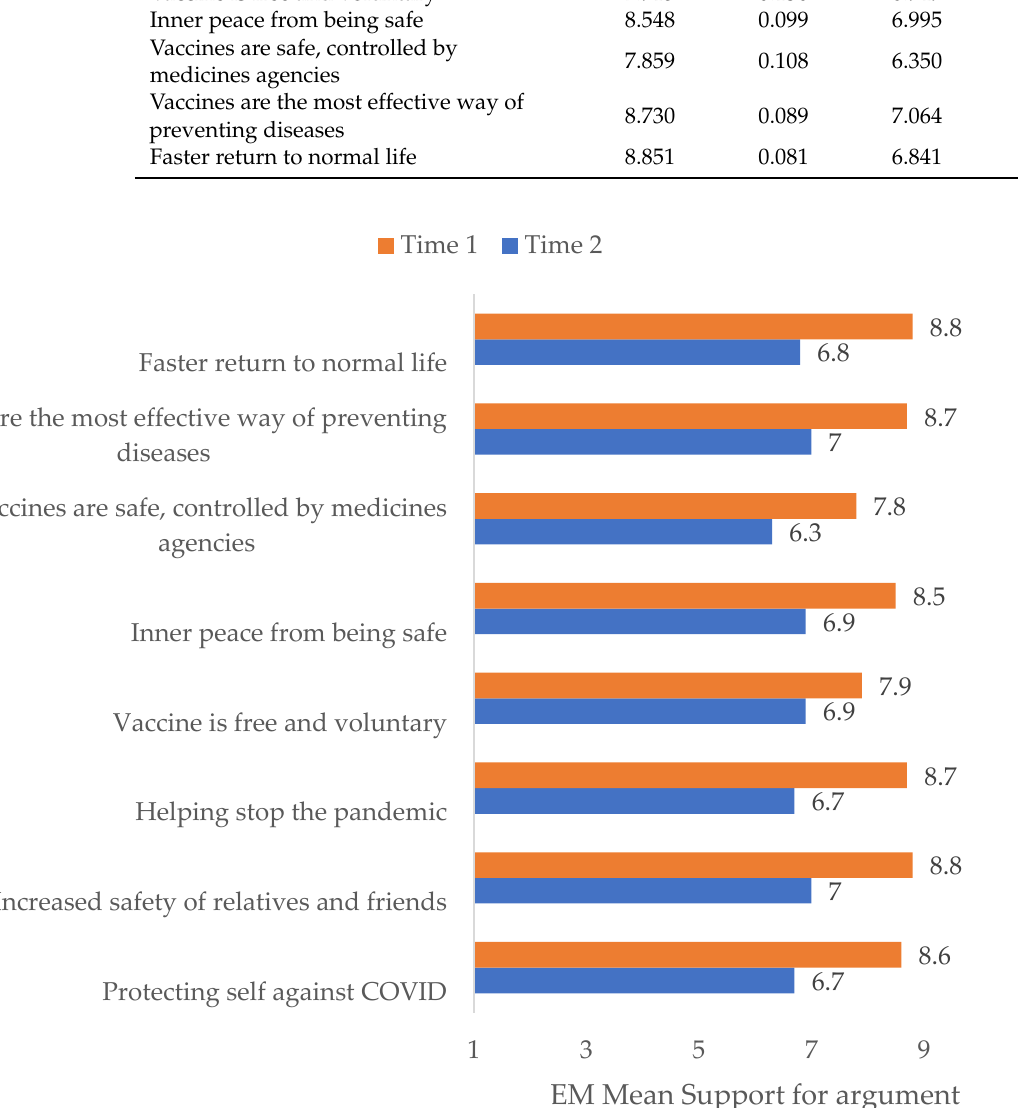
Figure 2. Reasons to get vaccinated against COVID-19 between Time 1 and Time 2.